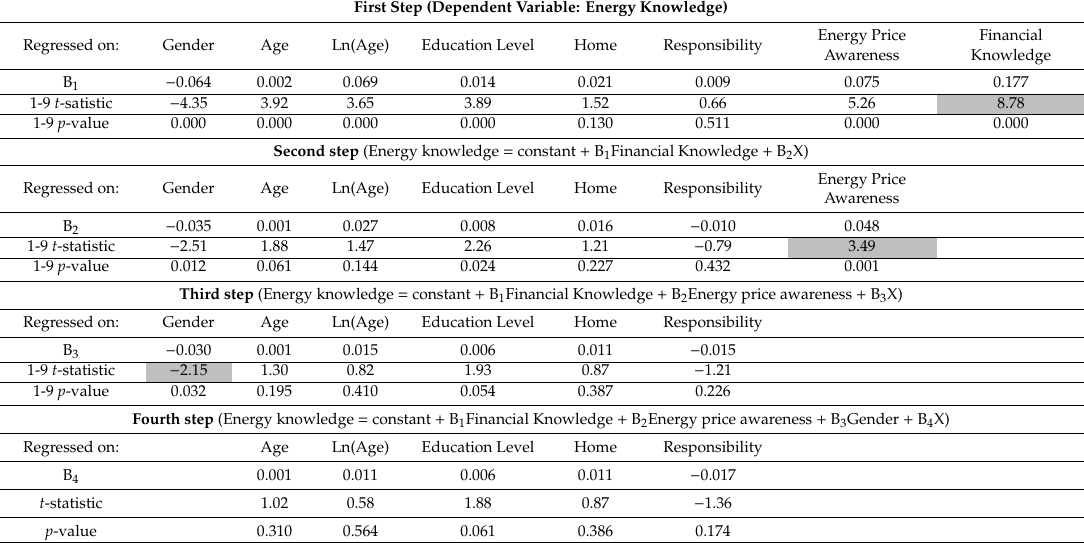
Table A1. Stepwise estimations considering energy knowledge as the dependent variable. First Step (Dependent Variable: Energy